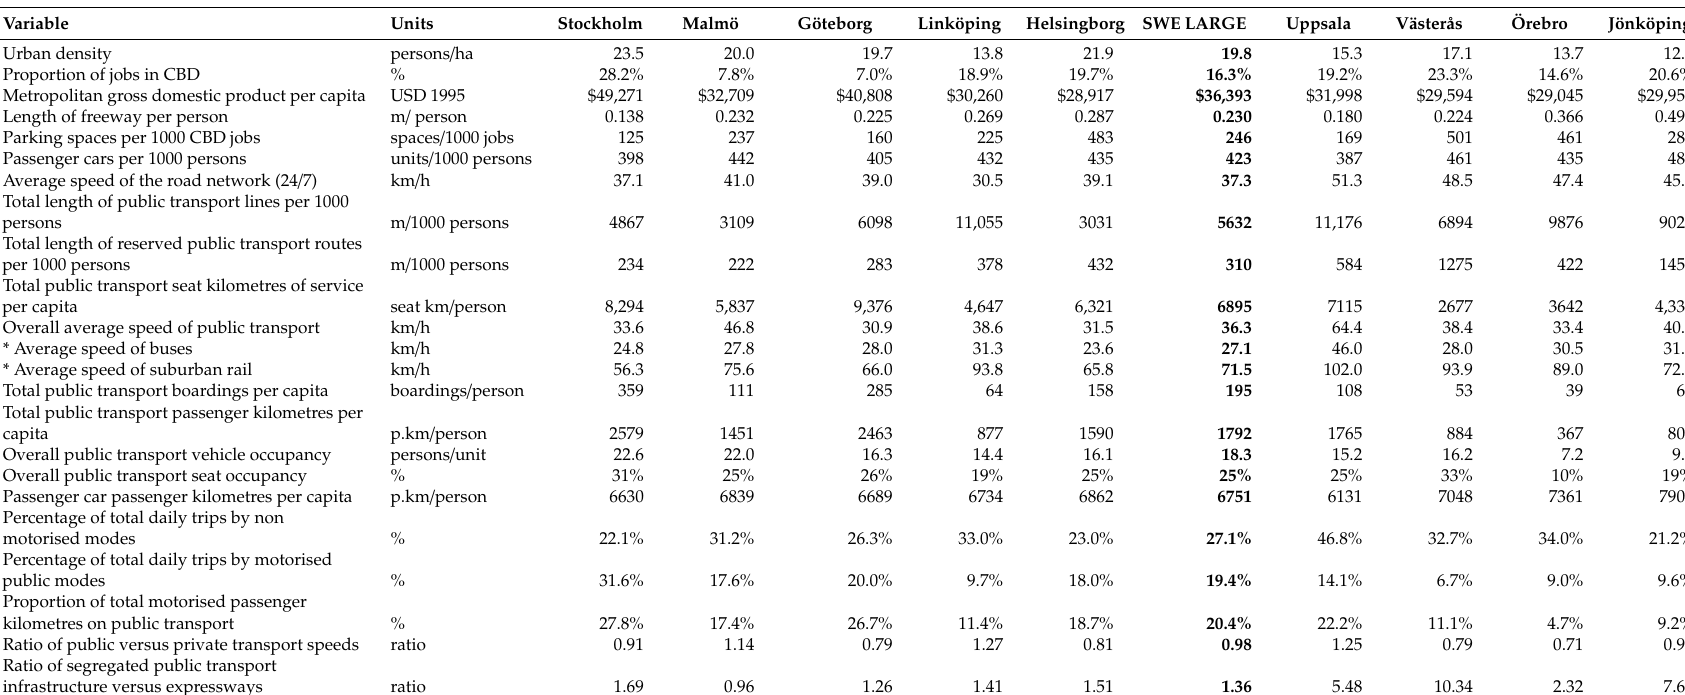
Table 4. Key transport and land use indicators in ten Swedish cities (2015), plus Freiburg im Breisgau (2015), as compared to American, Australian, Canadian, European and Asian cities